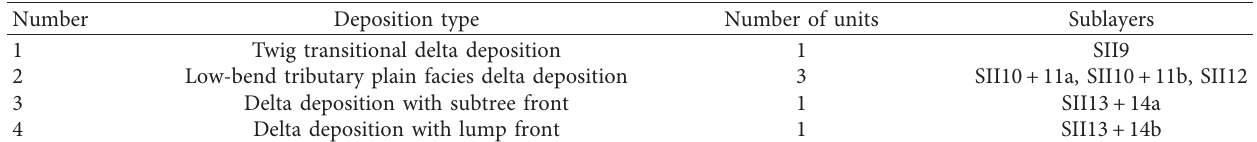
Table 9: B-2-X sediment unit